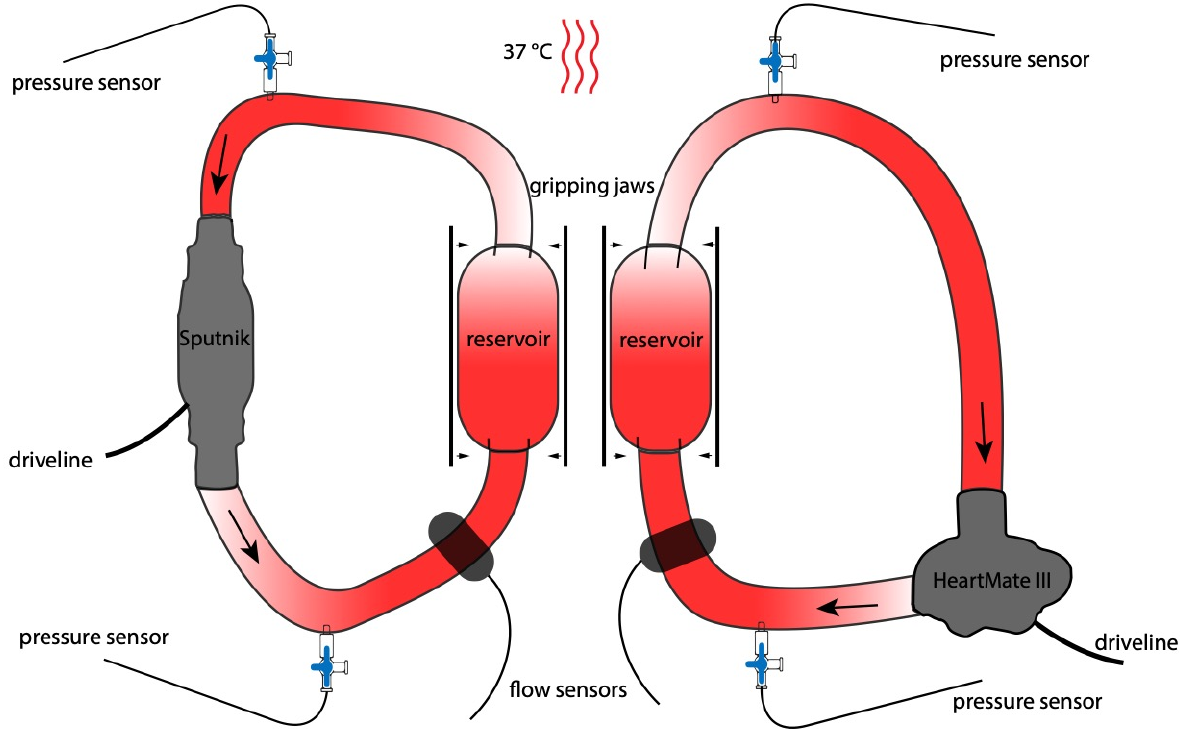
Figure 2. Assembly diagram of both test circuits. Large arrows: Direction of blood flow. Small arrow: Mechanical pressure on reservoirs.